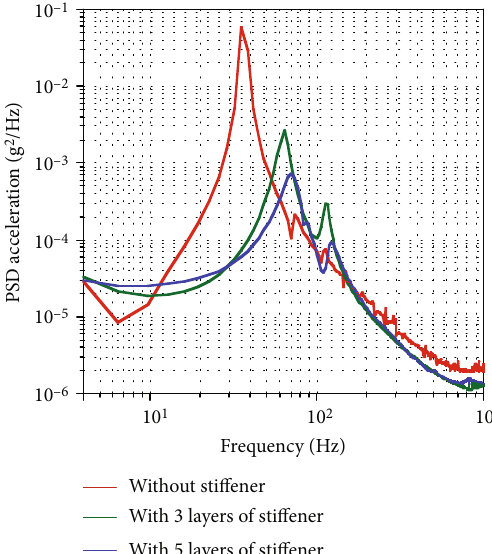
Figure 4: The PSD acceleration responses of the solar panel with various numbers of interlaminated sti ff eners.